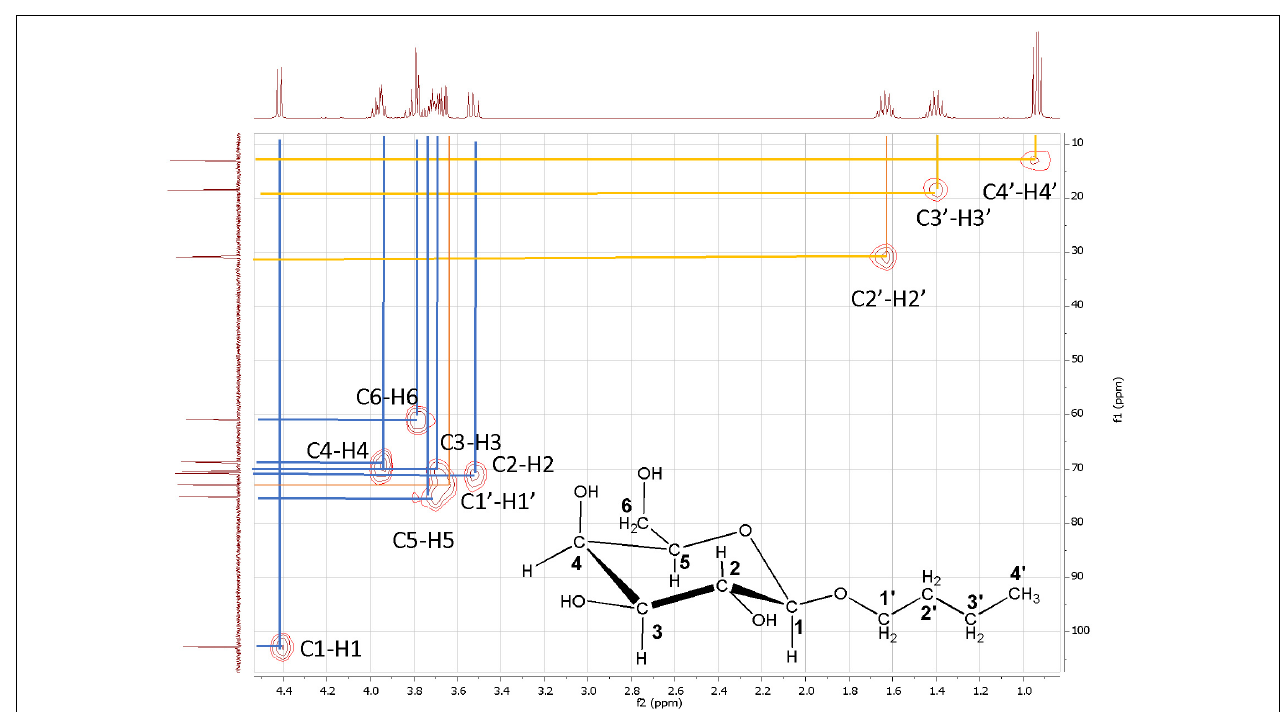
FIGURE 5 | Bidimensional NMR spectrum 13 C- 1 H HSQC for butyl- β